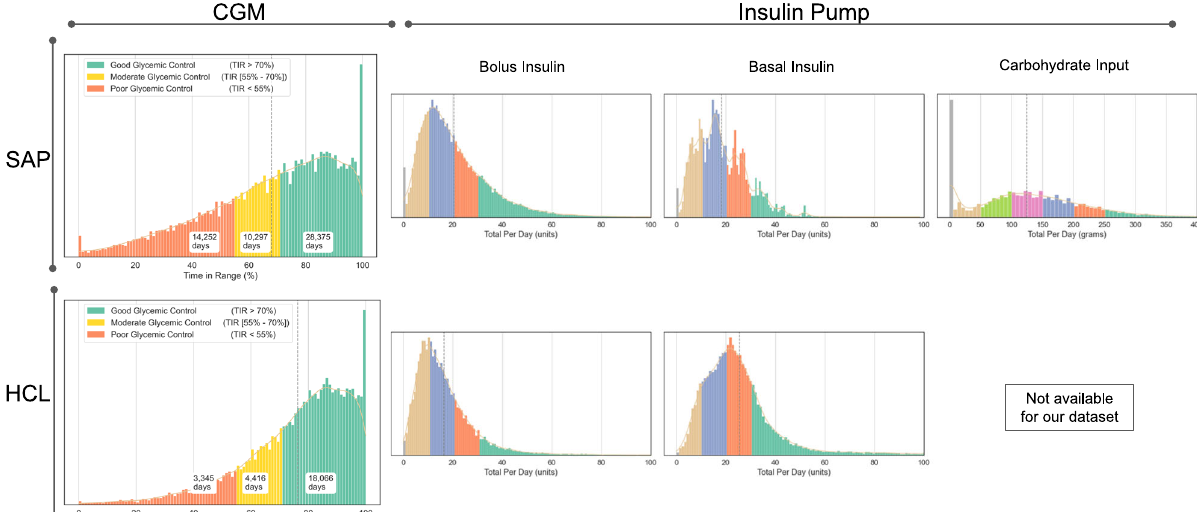
Fig. 2 Overview and distribution of digital data. This fi gure shows the distributions across subjects in the SAP and HCL population for time in range from the CGMs and total bolus, basal and carbohydrate input per day from the insulin pumps. Table 1. Summary metrics for digital biomarkers in the SAP ( n = 100) and HCL ( n = 150) population. Dataset